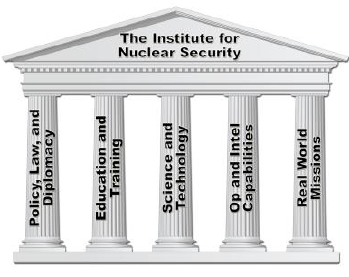
Figure 1: The thematic "pillars" of